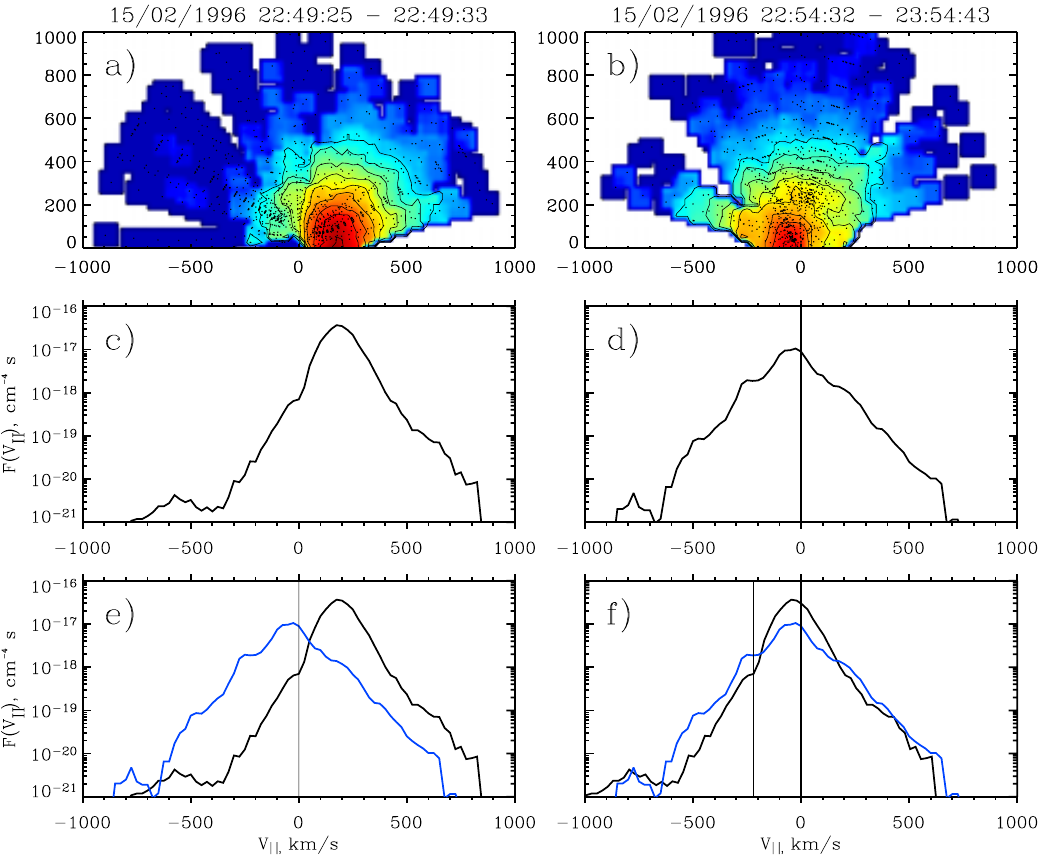
Fig. 17. A comparison is given of magnetosheath ion velocity distribution (panel (a) and panel (c) ) with typical 3-component distribution in the LLBL (panel (b) and panel (d) ). Upper diagrams are cuts through velocity distributions in the magnetic coordinate system, next row: the same distributions integrated over V ⊥ . Panel (e) shows spectra (c) and (d) superimposed without displacement along V k . Panel (f) is comparison of the LLBL spectrum (d) with magnetosheath spectrum (c) displaced to negative V k velocities for co-location spectra maximums. Vertical line indicates the amount of displacement of spectrum (c) along V k